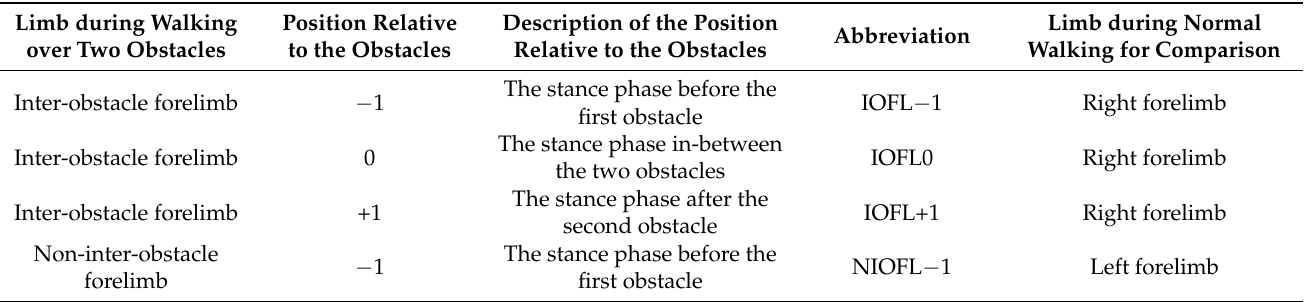
Table 2. Description of the abbreviations used during walking over two obstacles and the limbs with which they were compared during normal